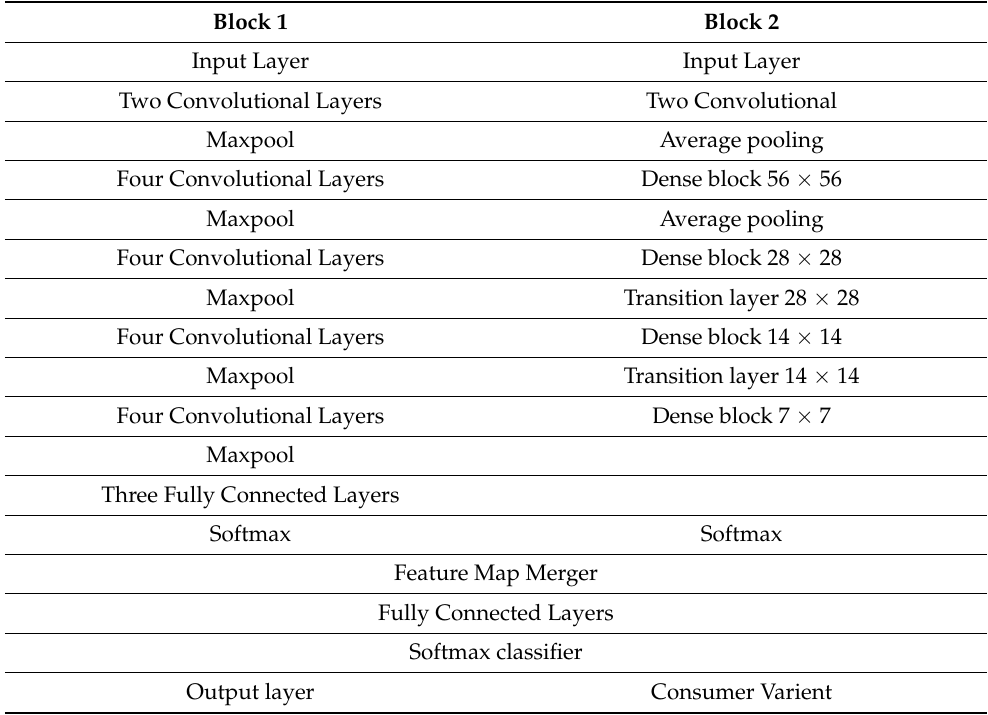
Table 3. The description of the ensemble